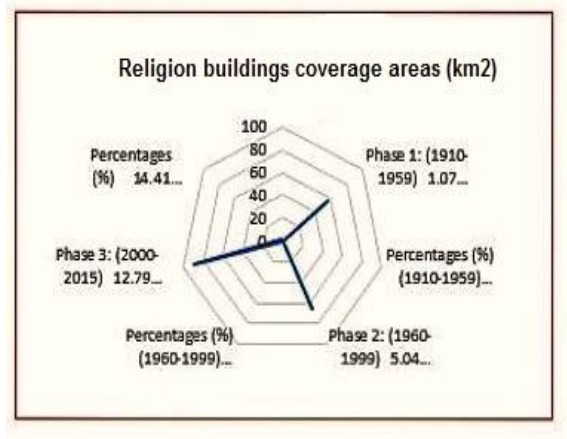
Figure 11. Land use coverage by the religion structures (Km 2 )